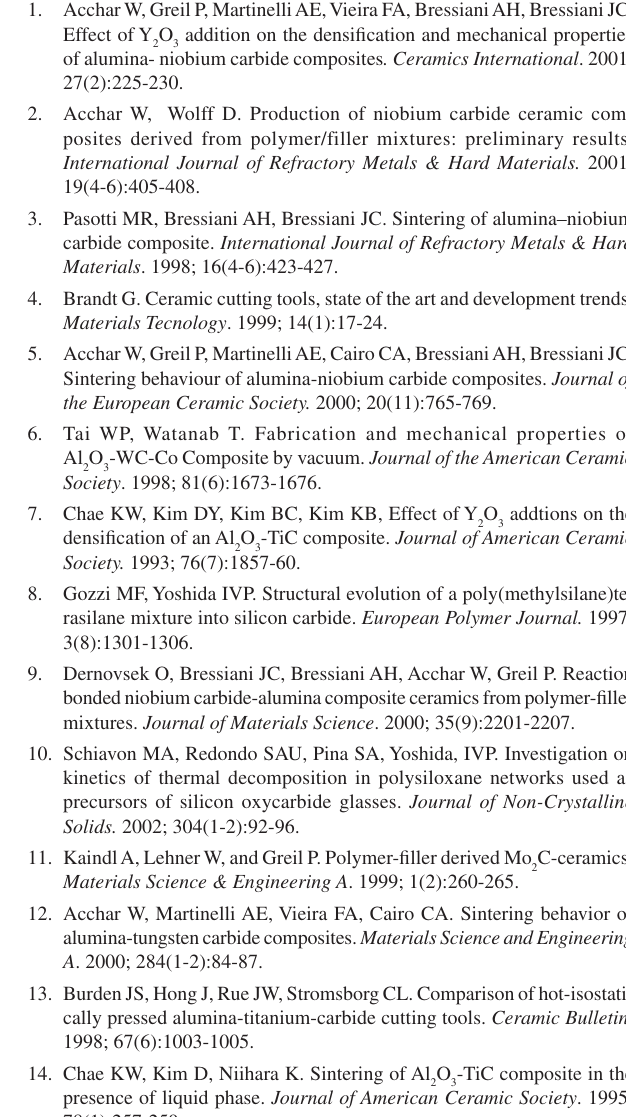
O -NbC) with smaller 2 3